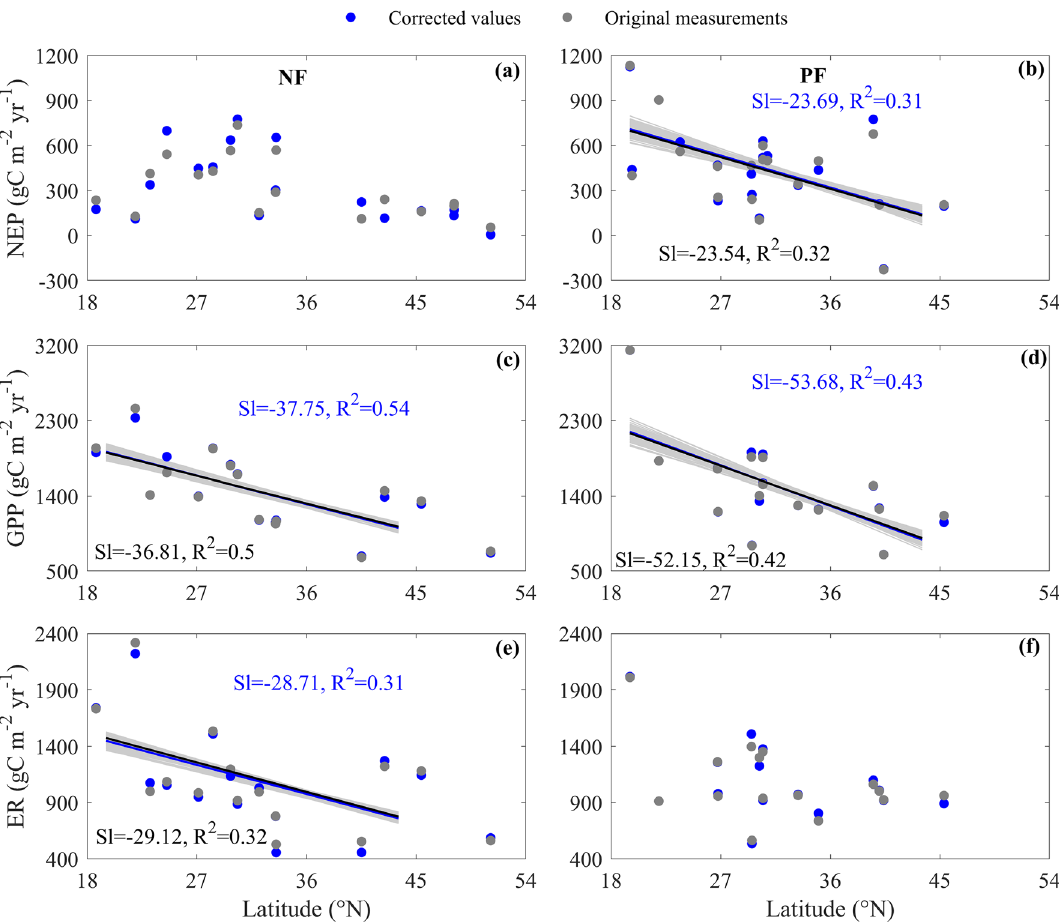
Figure 3. The latitudinal patterns of carbon fluxes over Chinese naturally regenerating forests (NF) and planted forests (PF). The carbon fluxes include net ecosystem productivity (NEP, a , b ), gross primary productivity (GPP, c , d ), and ecosystem respiration (ER, e , f ). Each panel is drawn with the corrected values (blue points) and original measurements (grey points), respectively. The blue and black lines represent the regression lines calculated from the corrected values and original measurements, respectively, with their regression statistics listed in blue and black letters. Only the regression slope (Sl) and R 2 of each regression are listed. The grey lines represent the regressions between carbon fluxes added by random errors and latitude. Only significant (p < 0.05) regression lines are drew in each